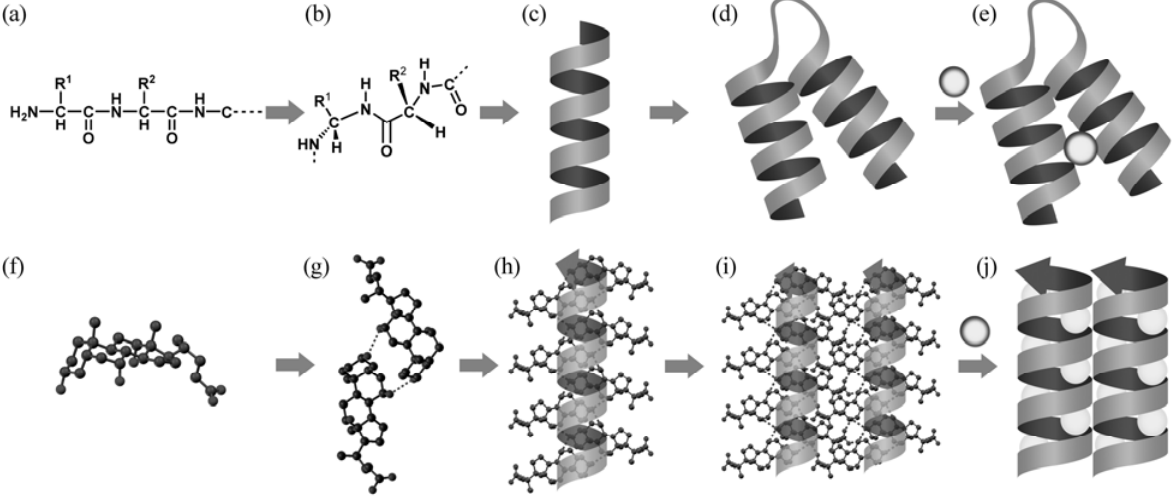
Figure 6. Hierarchical structures in proteins (upper) and steroids (lower). The peptide chain (a) is folded with a relative position between the two units (b), yielding a helical chain (c) and a bundle of the helical chains (d), followed by a host-guest complexation (e). The steroidal molecules (f) associate to make a bimolecular assembly (g) and a helical assembly (h), followed by a bundle of the chains (i). The cavities among the helices accommodate guest components